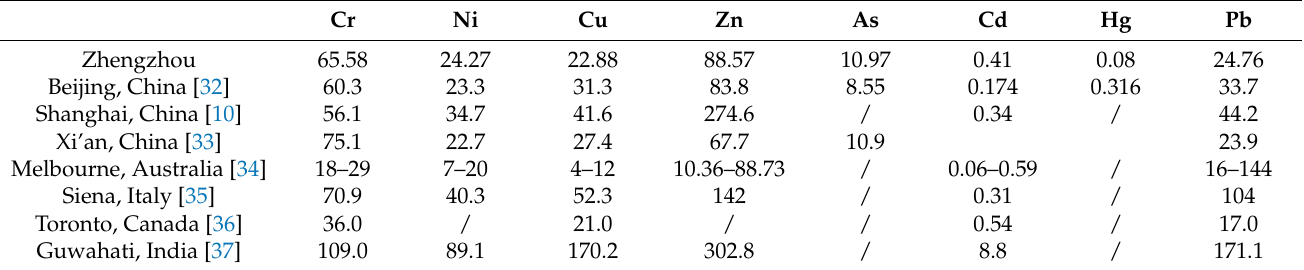
Table 3. Comparison of PTEs (mg/kg) in roadside soils with the previous literature from China and other